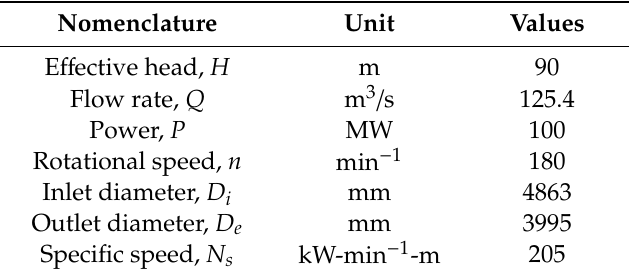
Table 1. Design specification of the 100 MW class Francis turbine.